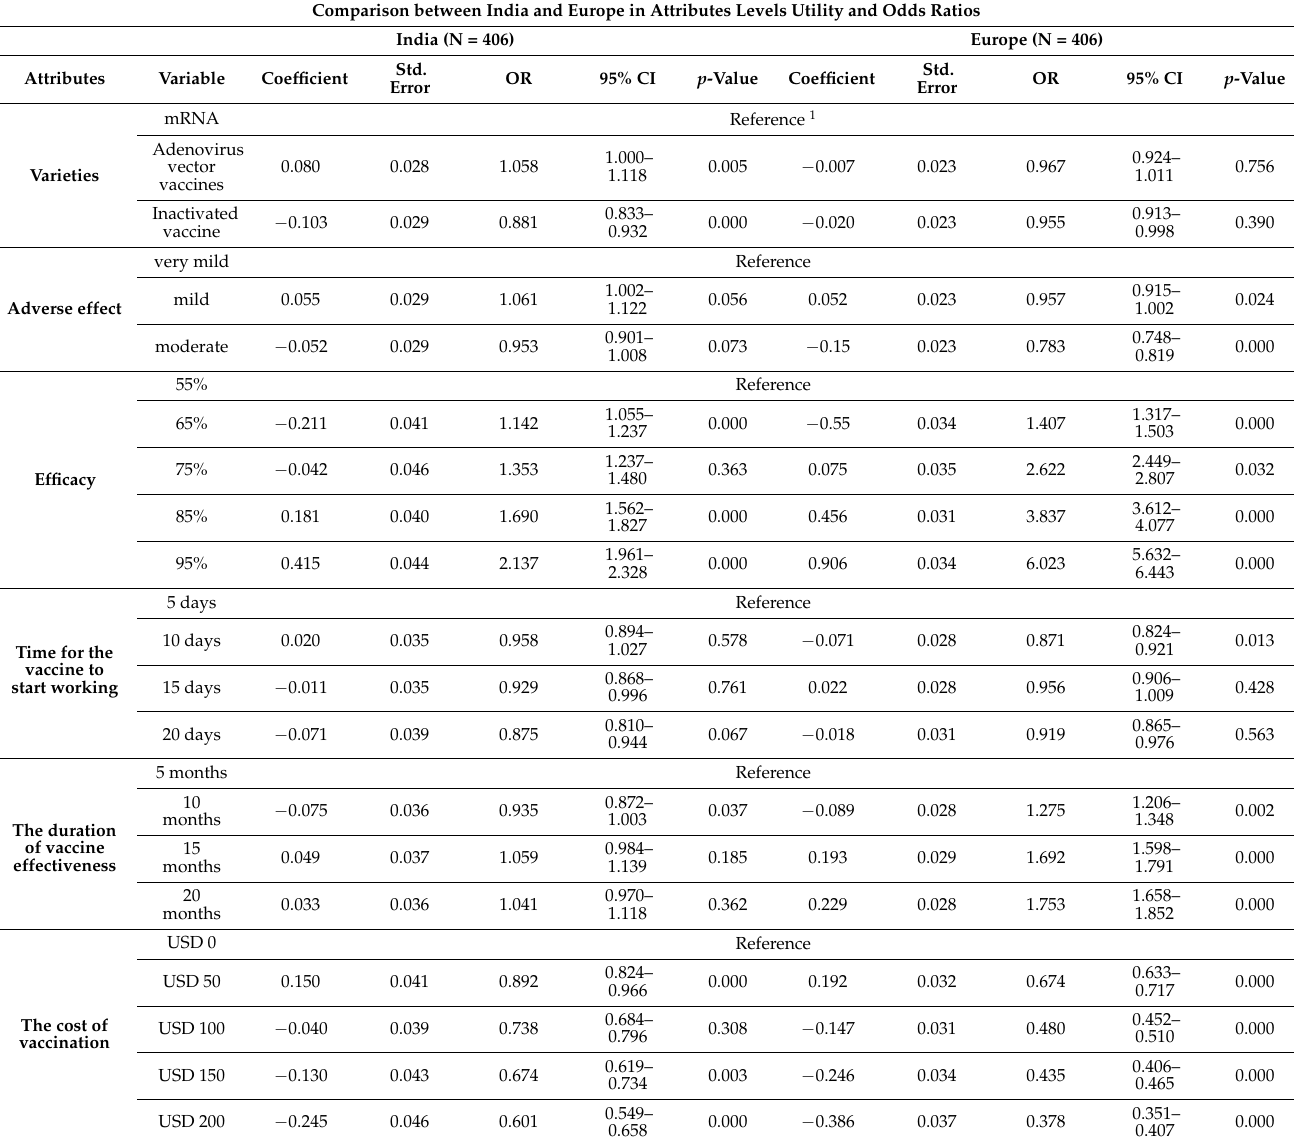
Table 3. Comparison between India and Europe in terms of Attribute Level Utility and Odds Ratios. Comparison between India and Europe in Attributes Levels Utility and Odds